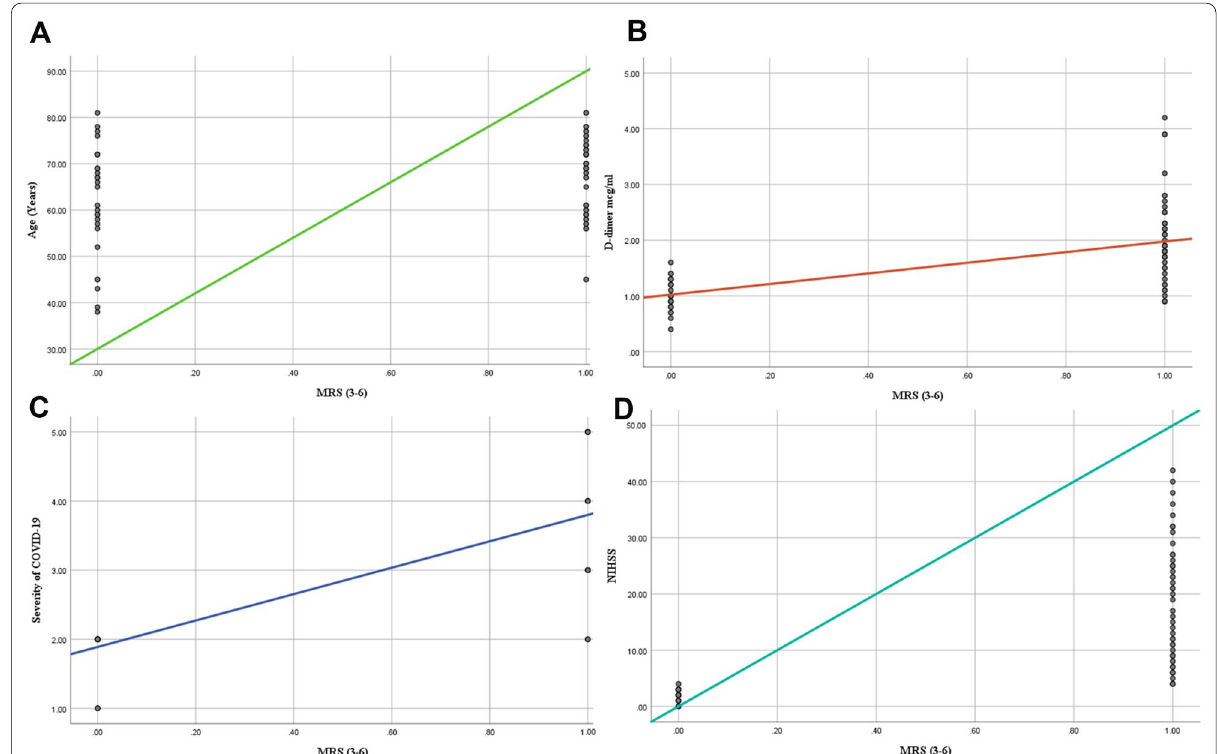
Fig. 1 Scatter plots with regression lines showing the association between Modified Rankin Scale of 3–6 grade among patients with COVID-19 and A Patient’s age (Years) B D-dimer mcg/ml C Severity of COVID-19 Symptoms, D National Institutes of Health Stroke Scale for severity of stroke at